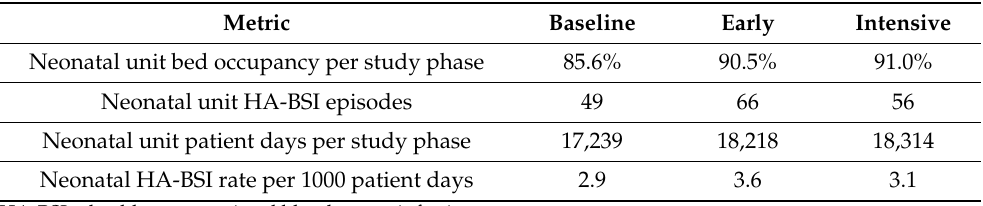
Table 4. Neonatal unit healthcare-associated bloodstream infection rate. Metric Baseline Early Intensive Neonatal unit bed occupancy per study phase 85.6% 90.5% 91.0% Neonatal unit HA-BSI episodes 49 66 56 Neonatal unit patient days per study phase 17,239